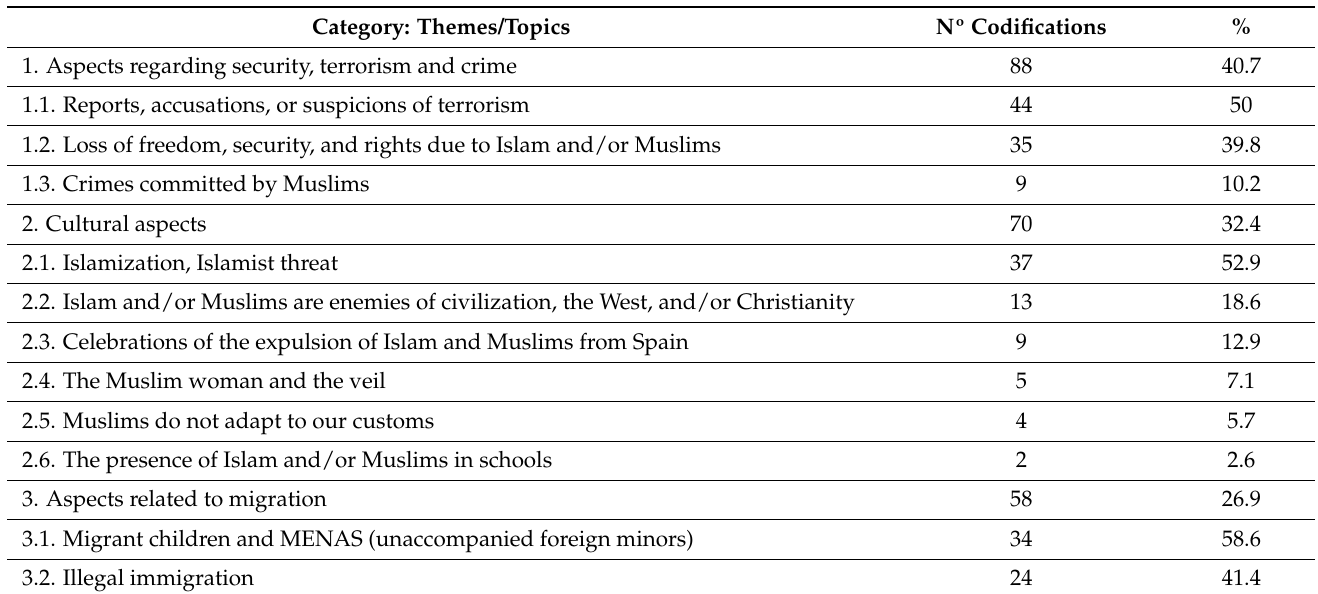
Table 1. Themes/topics present in publications by Vox (@vox_es) that concern Islam and/or Muslims during